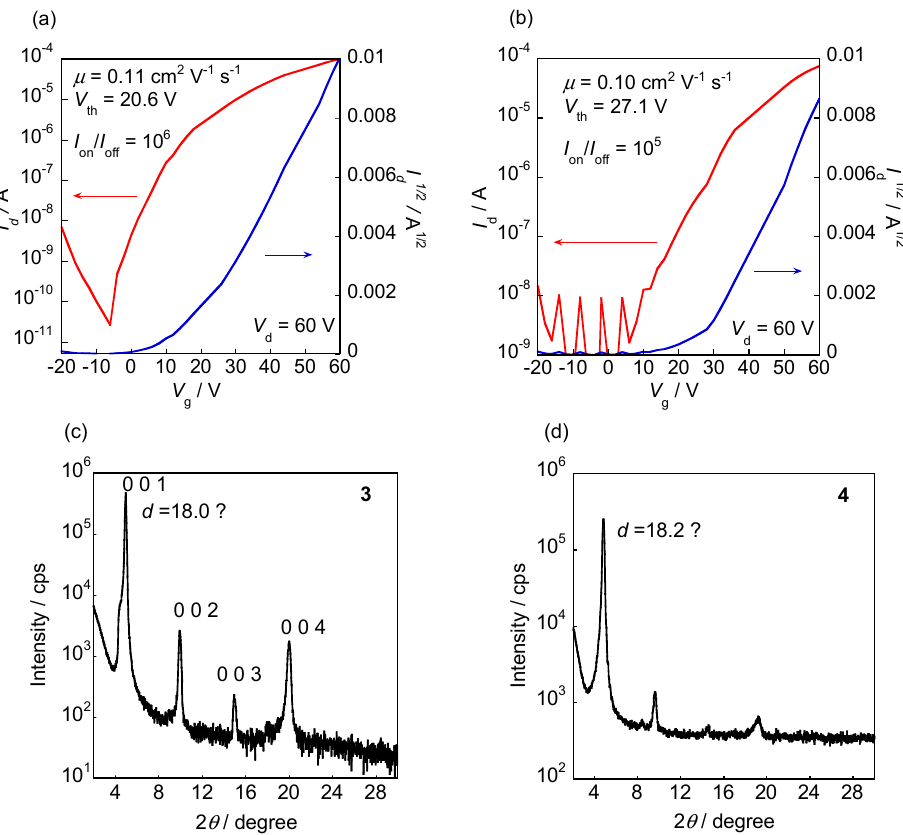
Figure 6. Transfer characteristics of 3 - ( a ) and 4 - ( b ) based n-type thin-film transistors (TFTs) evaluated under ambient conditions, and out-of-plane X-ray diffraction (XRD) patterns of vapor-deposited thin films of 3 ( c ) and 4 ( d ) on the Si/SiO 2 substrate at 150 ° C.